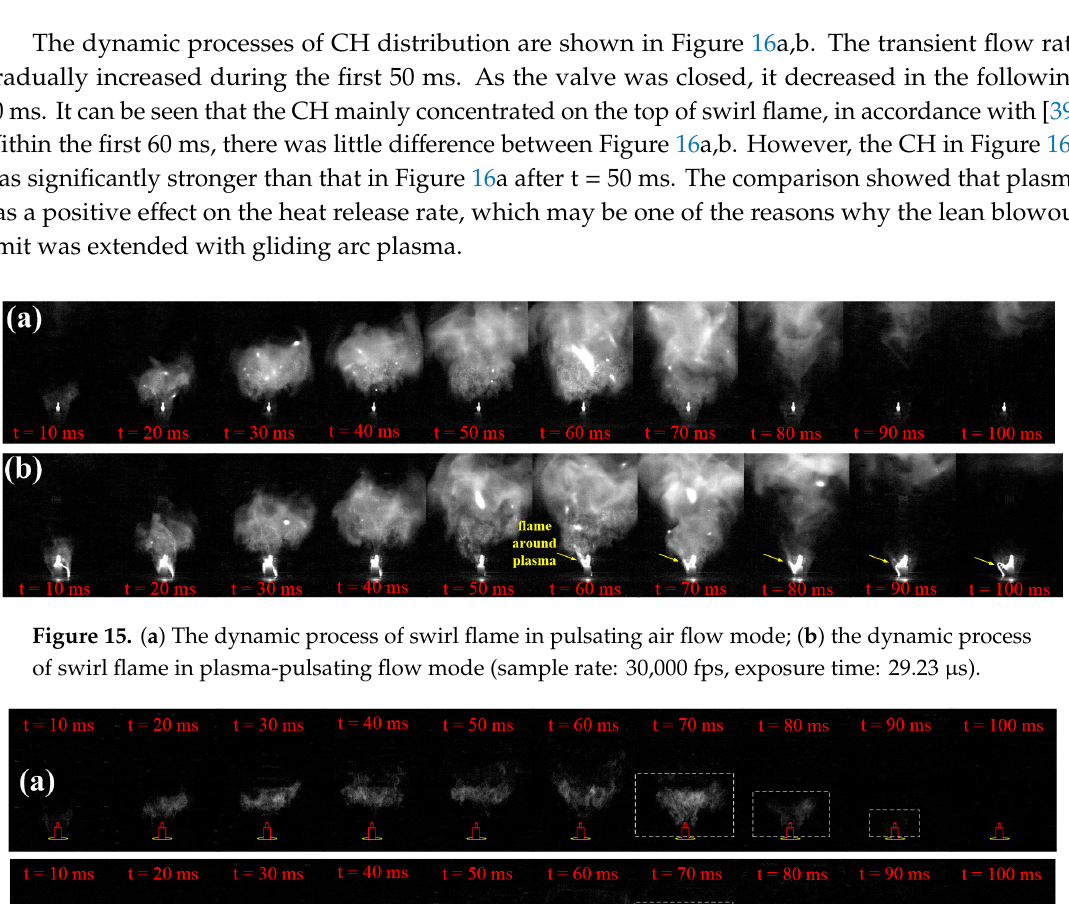
Figure 16. ( a ) The dynamic process of CH distribution in pulsating air flow mode; ( b ) The dynamic process of CH distribution in plasma-pulsating air flow mode (sample rate: 1000 fps, exposure time: 1